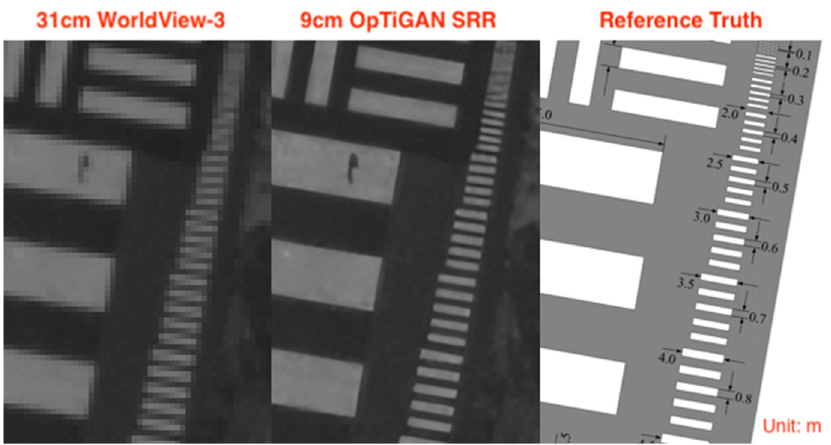
Figure 1. Example of the original 31 cm WorldView-3 image and the 9 cm OpTiGAN SRR result (WorldView-3 image, Maxar, 2020. Data provided by the European Space Agency).